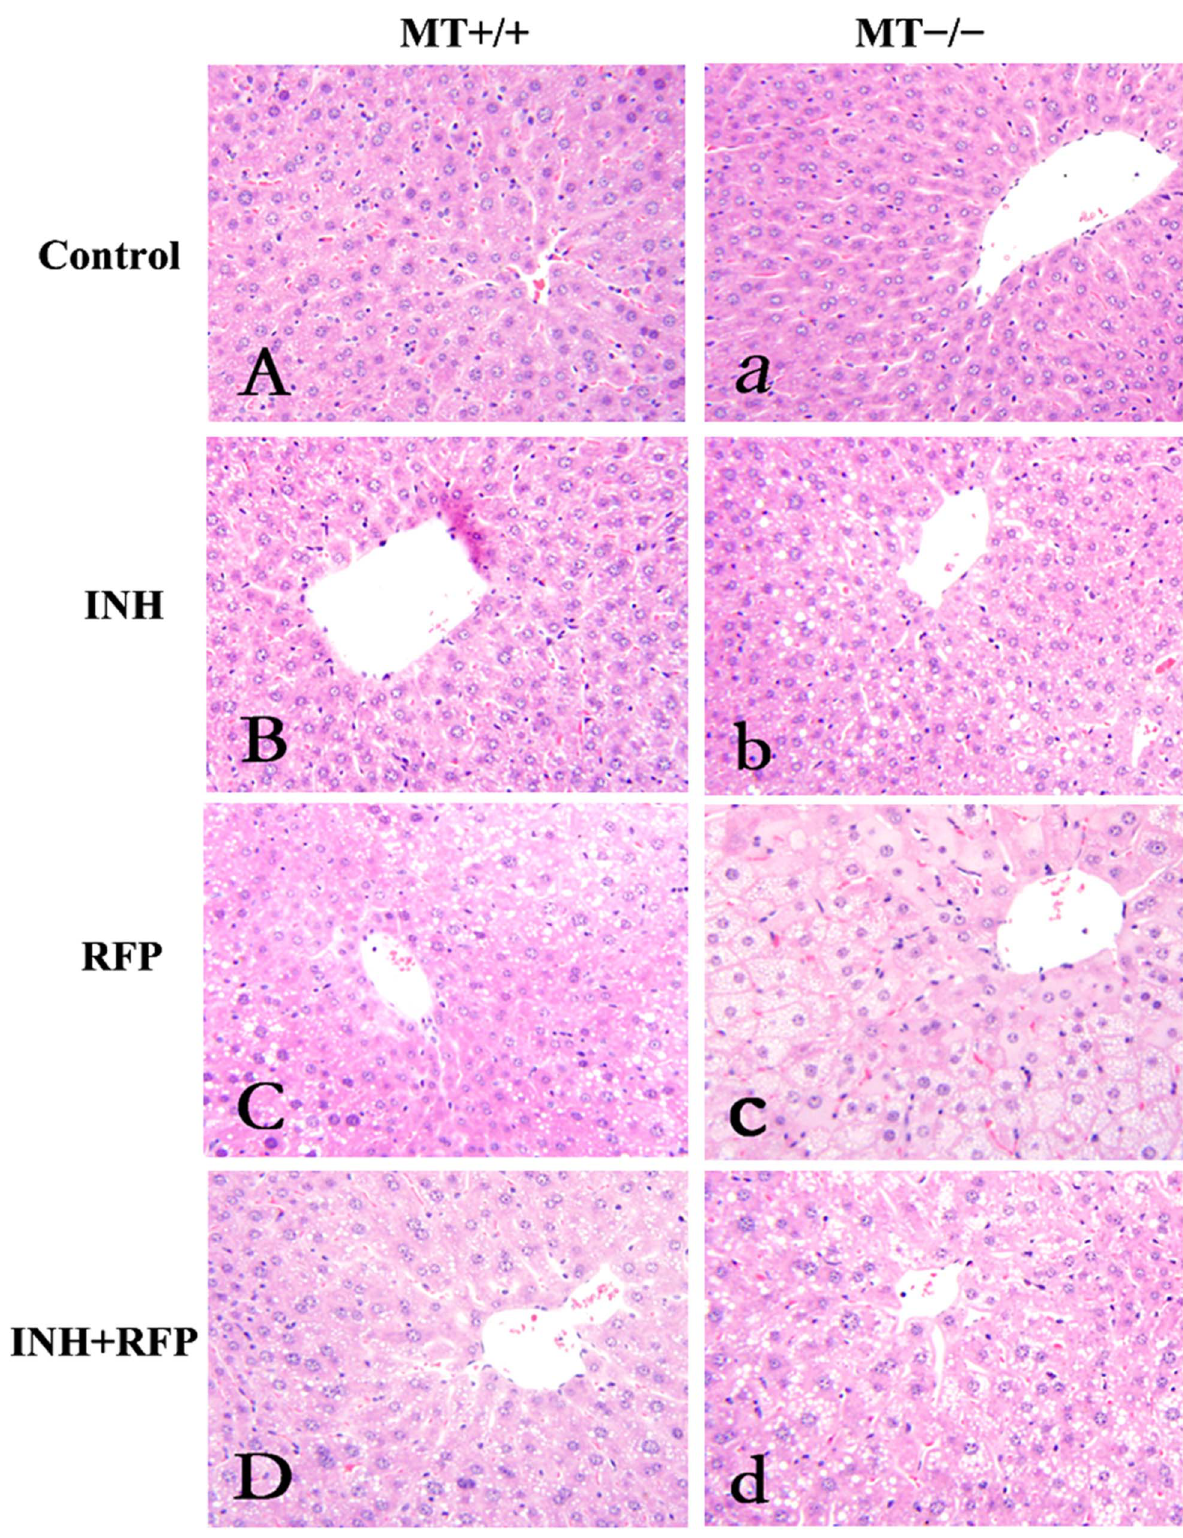
Figure 2. Liver histopathology of wild-type (MT + / + ) and MT 2 / 2 mice treated with INH and RFP. INH/RFP (alone or in combination) induced apparent histopathological changes in both types of mice livers as exhibited by hepatocellular swelling, vacuolization, fatty degeneration, and these changes were more prominent in MT 2 / 2 mice. Livers from the MT + / + mice and MT 2 / 2 mice were demonstrated in (A)–(D) and (a)–(d), respectively. H&E staining. Magnification, 6 200.